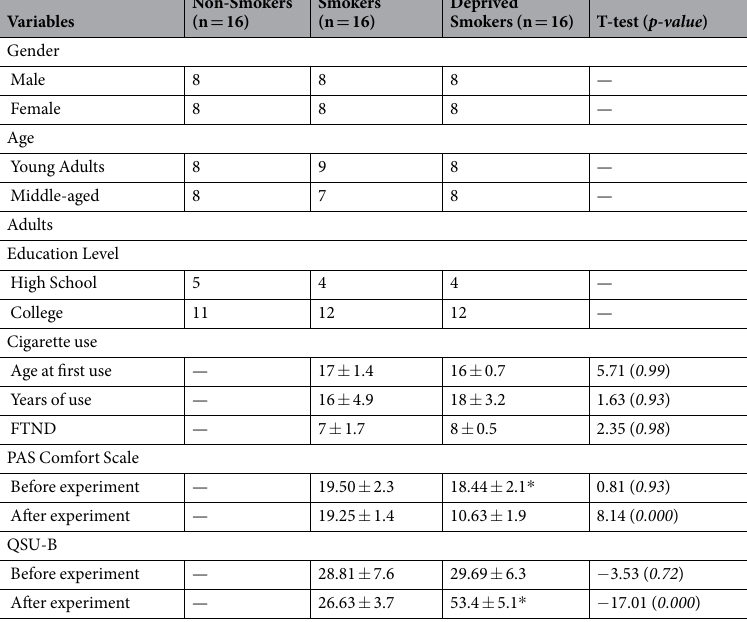
Table 1. Sample characteristics (N = 48). * Statistically significant difference at pairwise comparison between deprived smokers ( p <